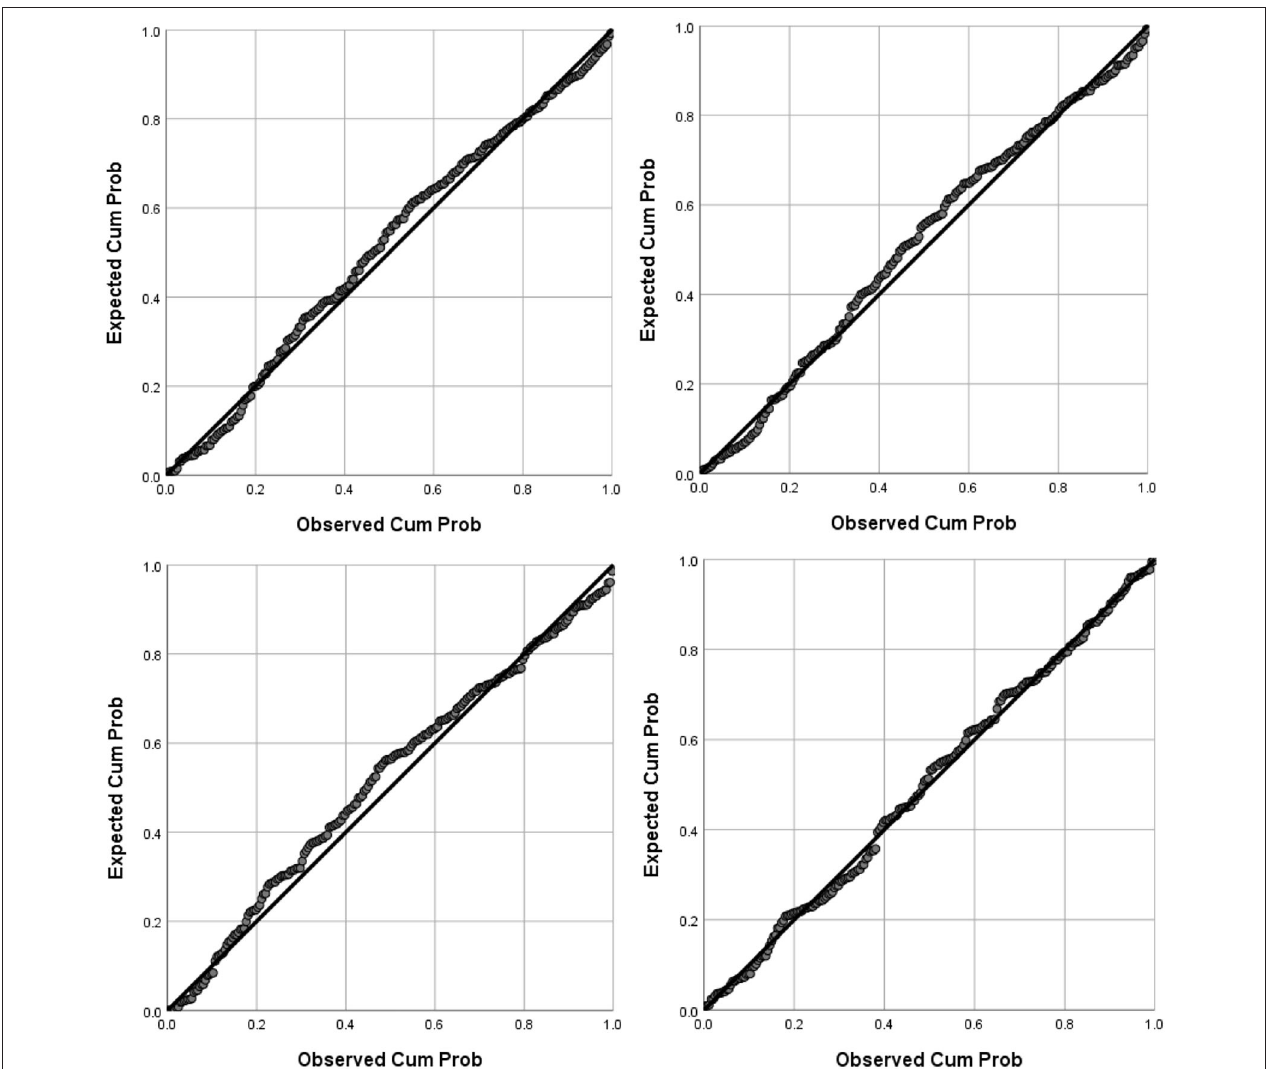
FIGURE 1 | Tests of normality using the P-P plot of regression standardized residuals: Total (top left), DDF (top right), DIF (bottom left), EOT (bottom